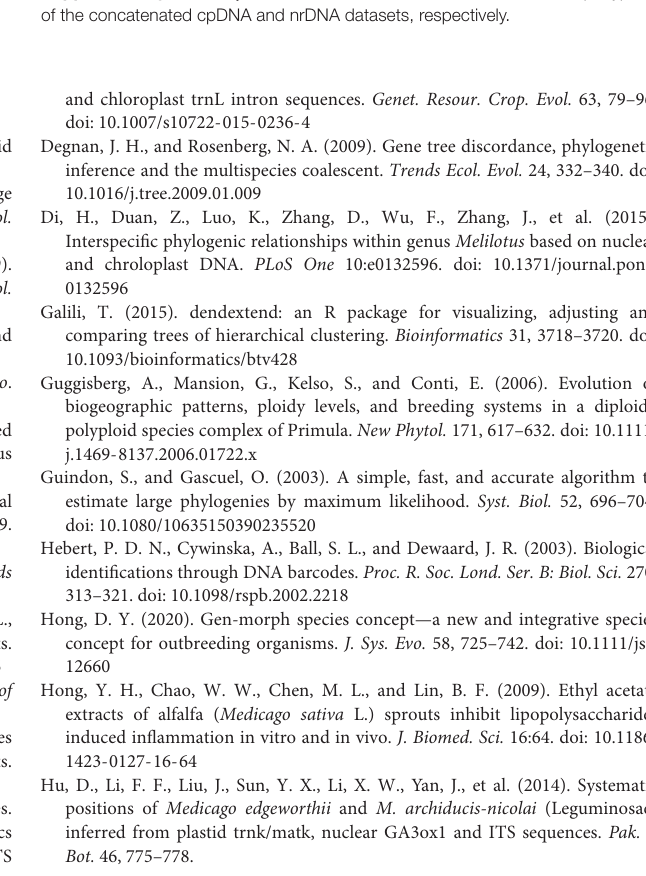
Supplementary Table 4 | Morphological characters re-examined in Clades 1–5,